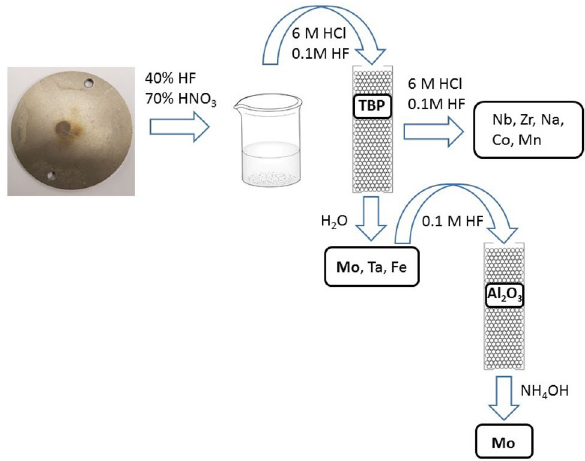
Figure 2. Schematics of the separation procedure for 93 Mo master